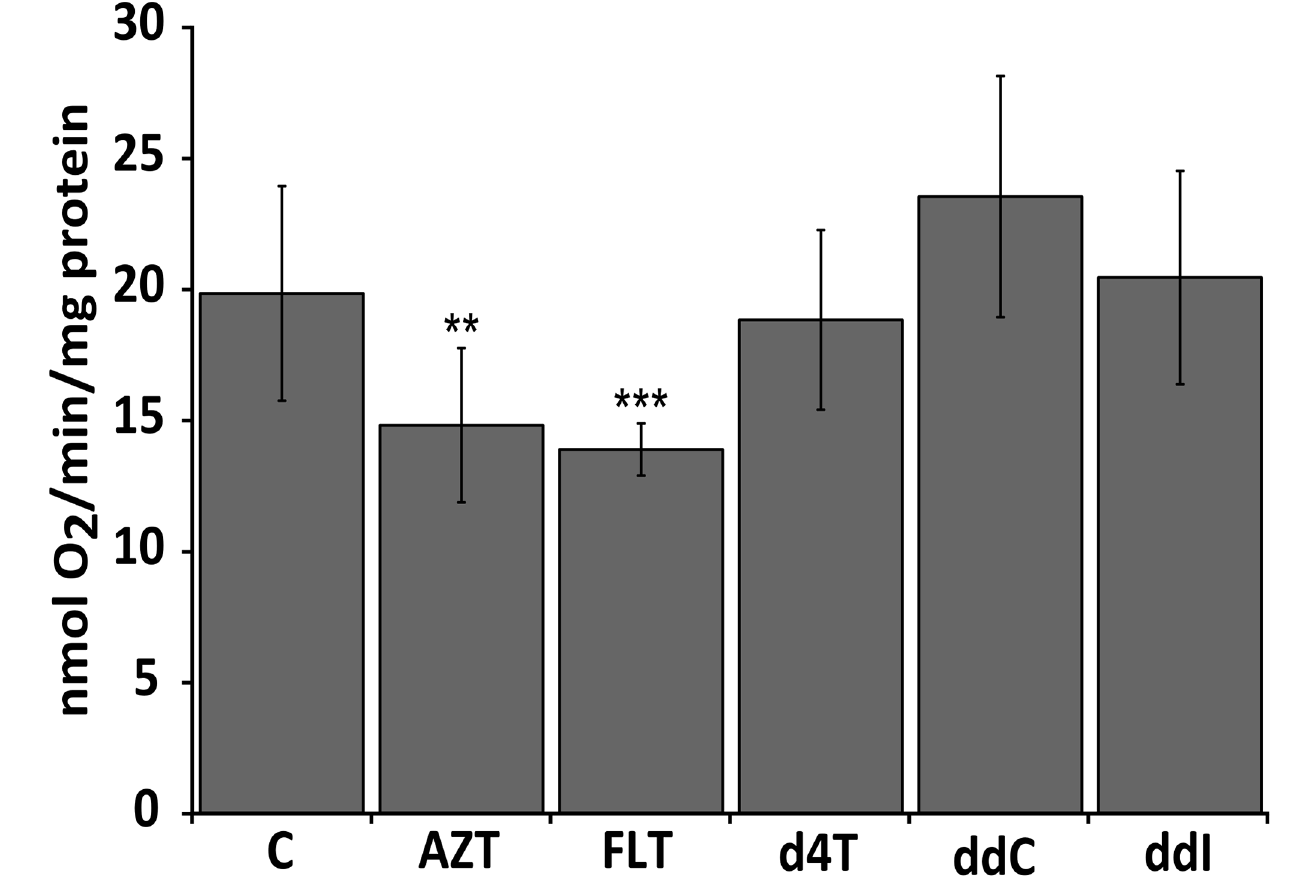
Fig 3. Oxygen consumption rates in NRTI exposed worms. Drug concentration was 100 μ M in all experiments. FLT and AZT exposed worms show a significantly reduced oxygen consumption rate compared to unexposed animals. C = Control, ** p-value < 0.01, *** p-value < 0.001. Significance was determined using a two tailed student ’ s t-test assuming unequal